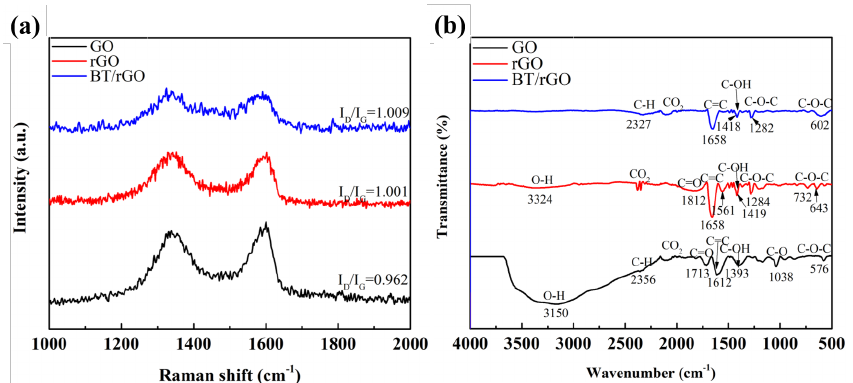
Figure 4. ( a ) Raman and ( b ) FTIR spectra of GO, rGO, and BT/rGO.